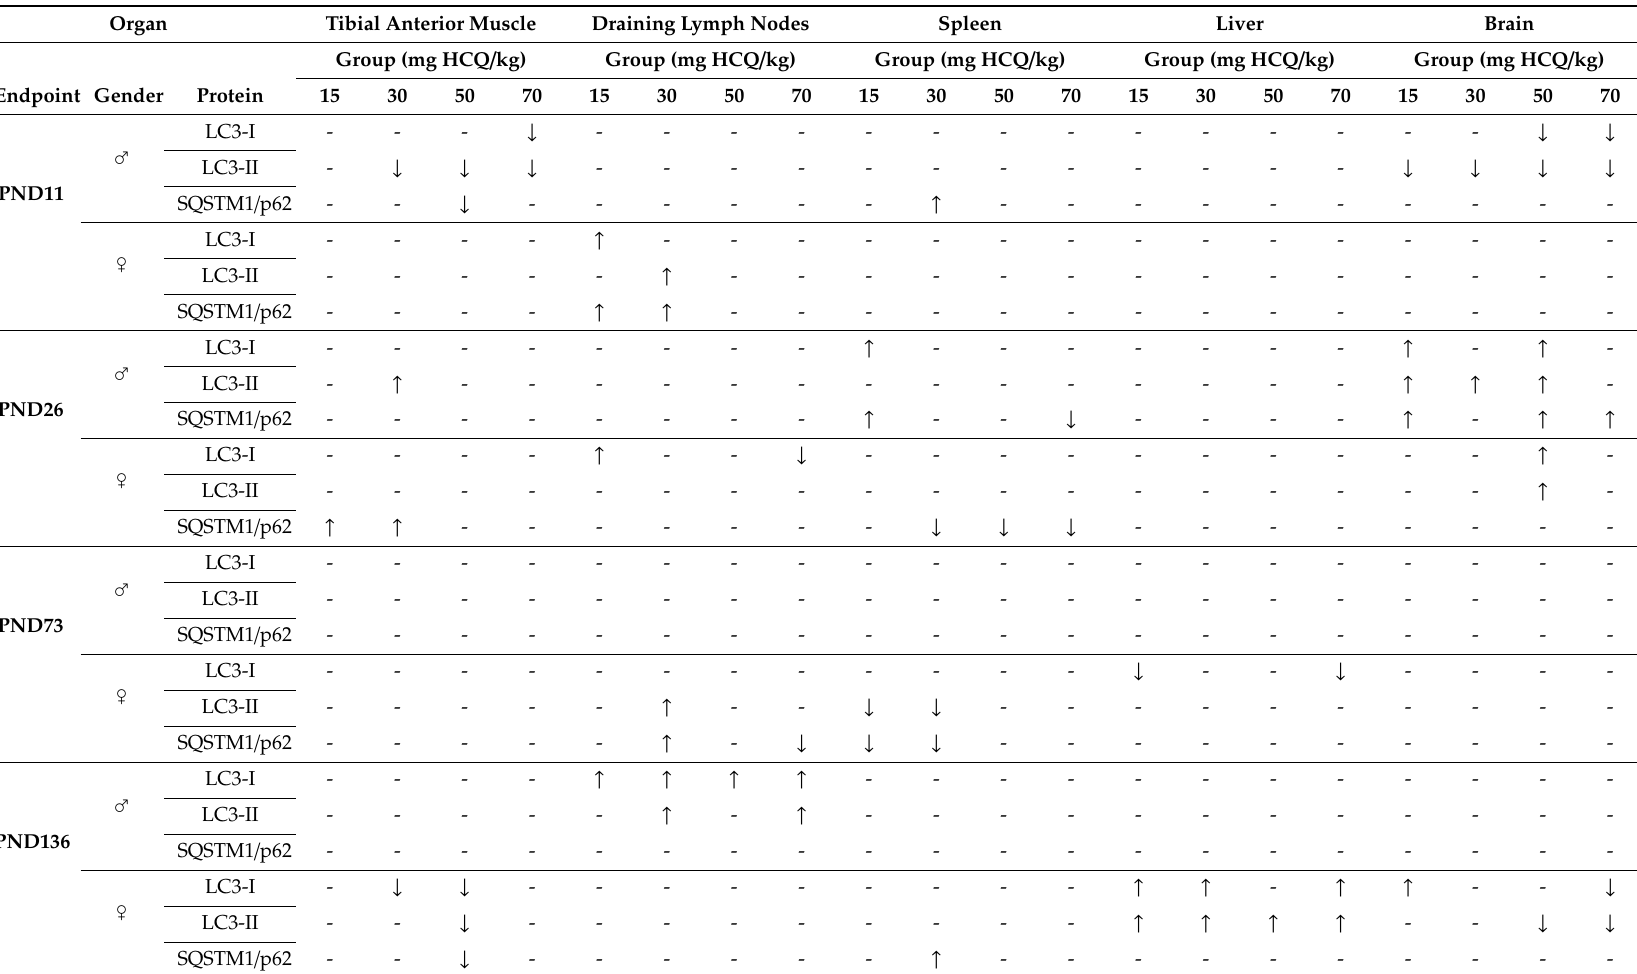
Table 2. E ff ects of HCQ treatment on LC3 and SQSTM1 / p62 proteins tissular level at several endpoints of juvenile